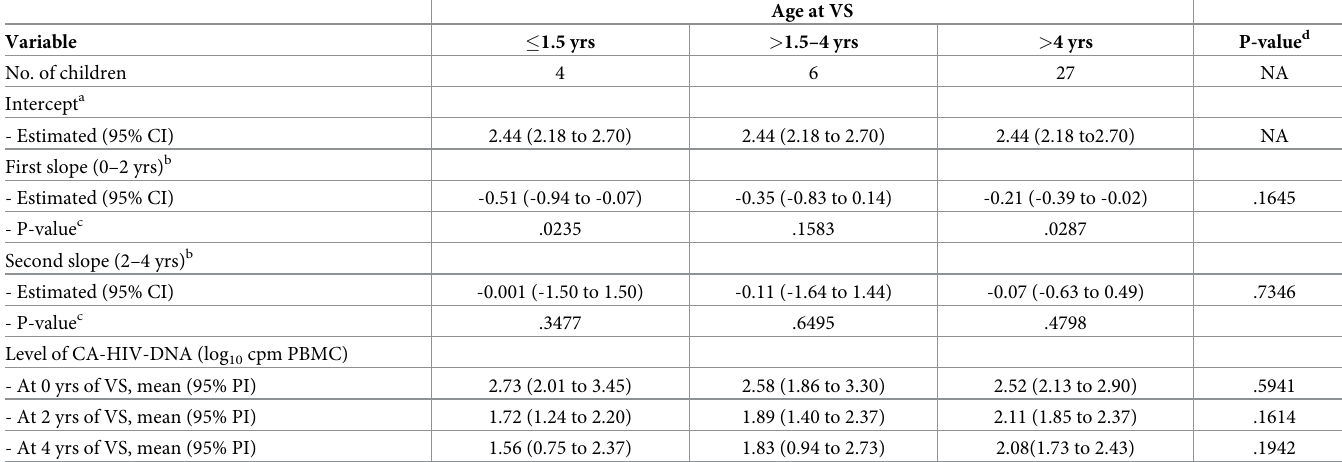
Table 3. Estimated decay rates and predicted means of cell-associated HIV-1 DNA level in PBMC over 4 years of sustained viral suppression according to theage at viral control.